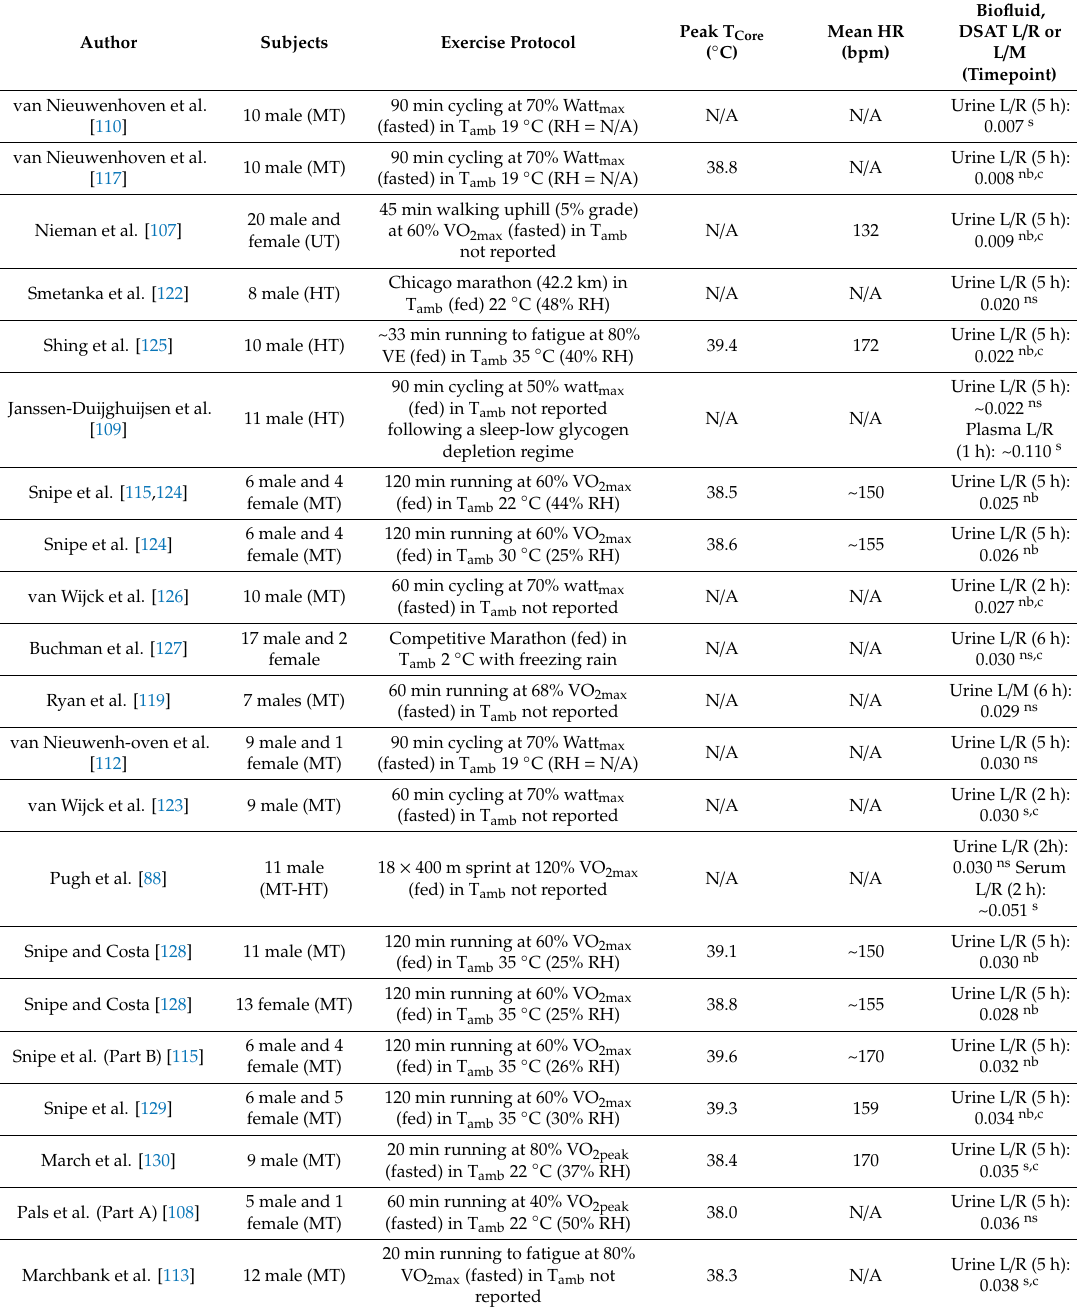
Table 2. Influence of acute exercise-(heat) stress on small-intestine DSAT